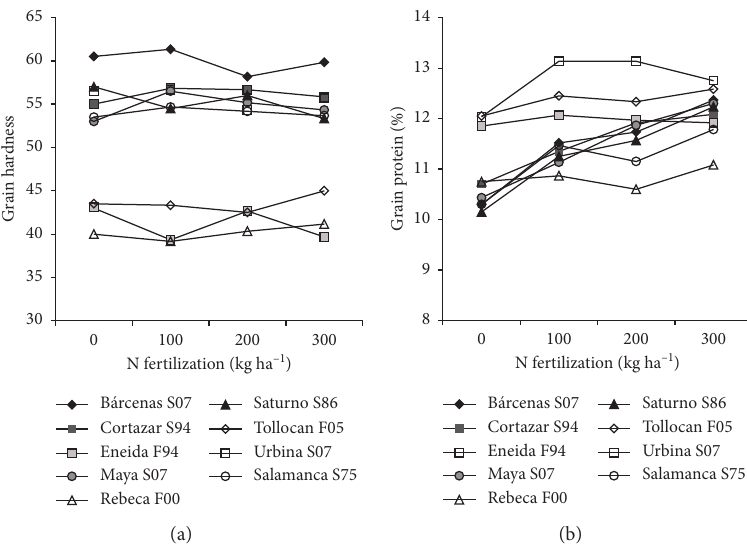
Figure 3: Relationship between grain hardness (a), grain protein (b), and nitrogen (N) fertilization rate in nine varieties of wheat.